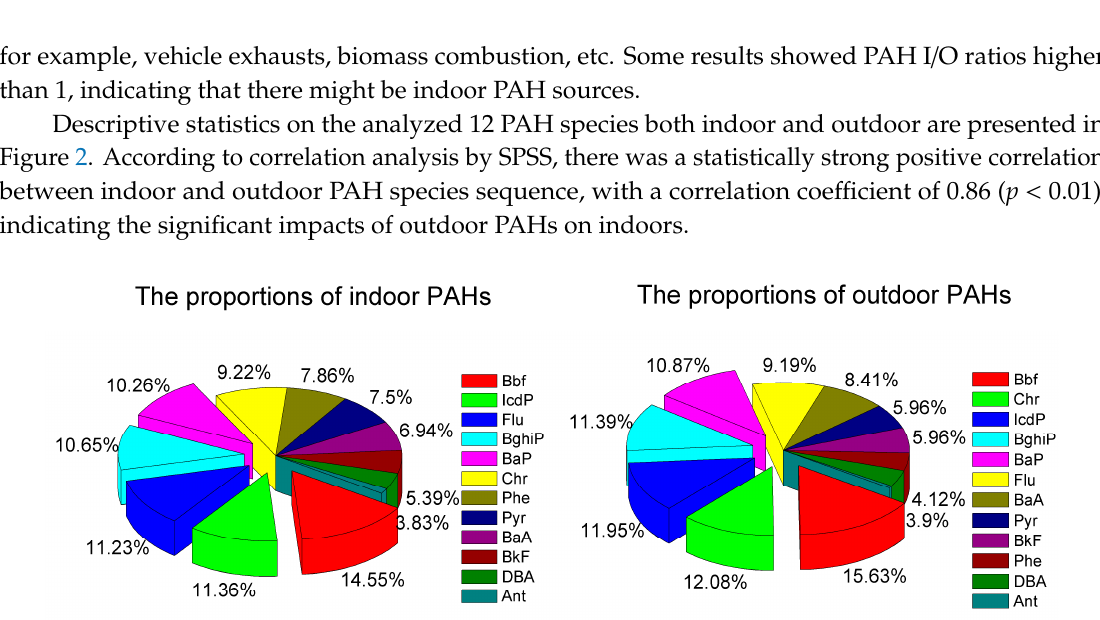
Figure 2. The proportion of PAHs in indoor/outdoor air.